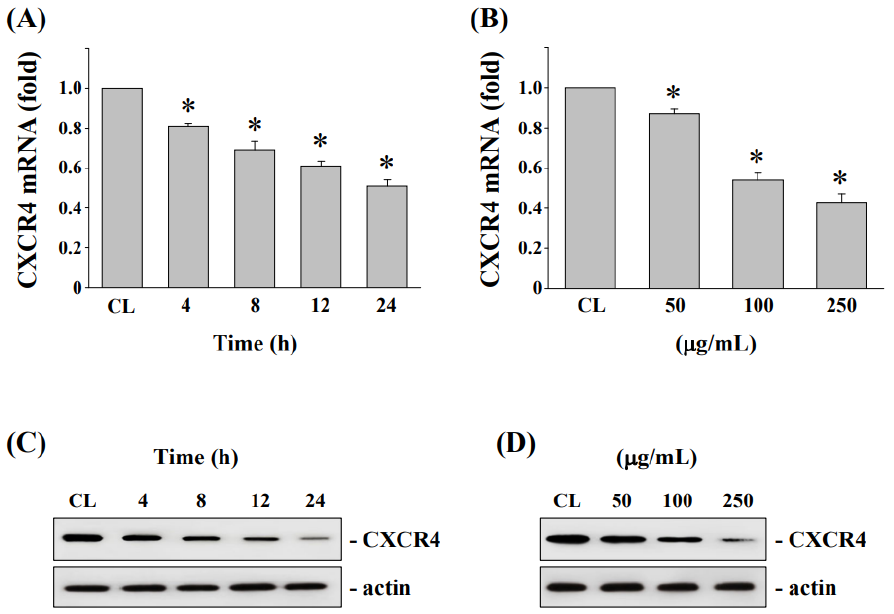
Figure 5. Fermented NaDES-ginger extract decreased the CXCR4 expression in a dose and time- dependent manner. ( A ) HCT-116/R cells were cultured in a complete medium and then exposed to fermented NaDES-ginger extract (100 µ g/mL) for 4, 8, 12, or 24 h. ( B ) Various concentrations of fermented NaDES-ginger extract (50–250 µ g/mL) were added to cells for 24 h in the complete medium. The total RNA was isolated and examined by real-time polymerase chain reaction for CXCR4 mRNA expression. Data represent the mean ± standard error of the mean from three independent experiments. * p < 0.05 vs. control cells. ( C ) and ( D ) After treatment as above, the cell extracts were examined by Western blot for determination of CXCR4 protein levels. Results in ( C , D ) are representative of three independent experiments with similar results.